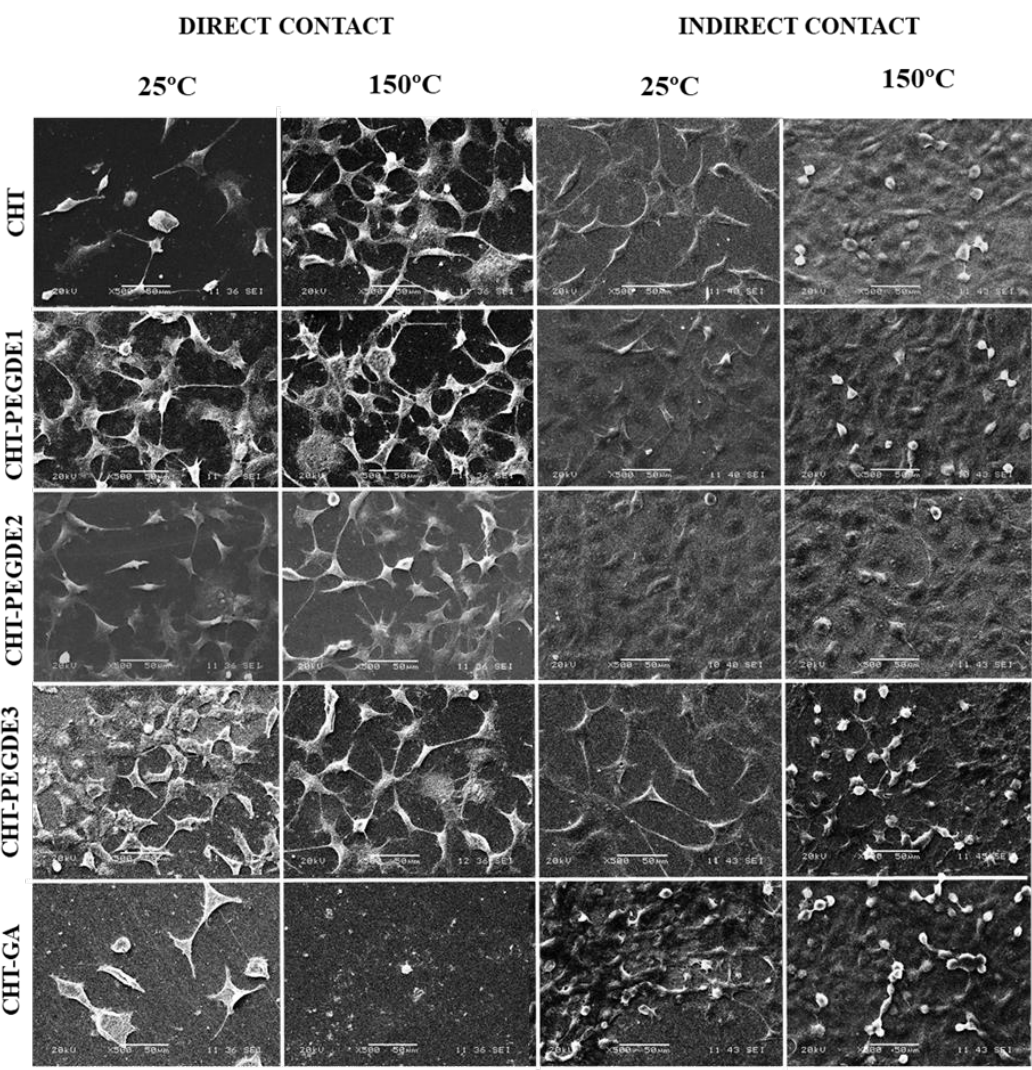
Figure 7. SEM images of osteoblast seeded onto CHT scaffolds on direct and indirect contact dried at 25 °C and direct and indirect contact dried at 150 °C.